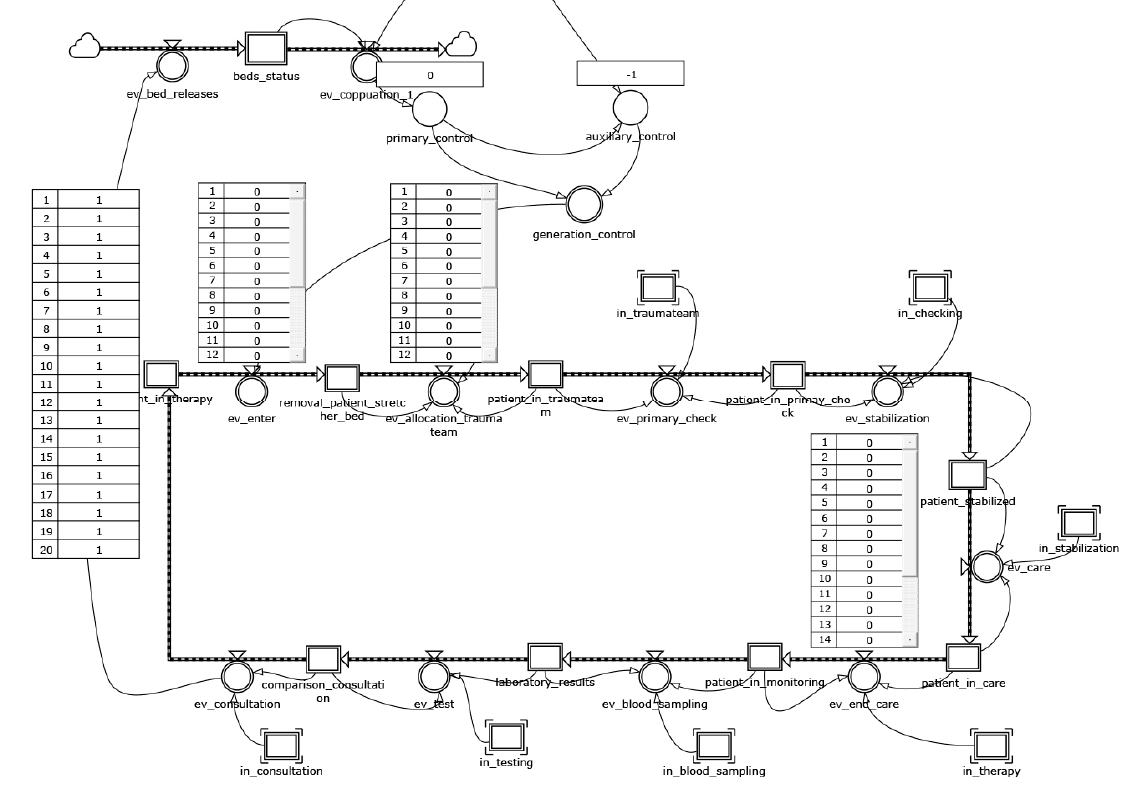
Figure 2. The chain of events module.